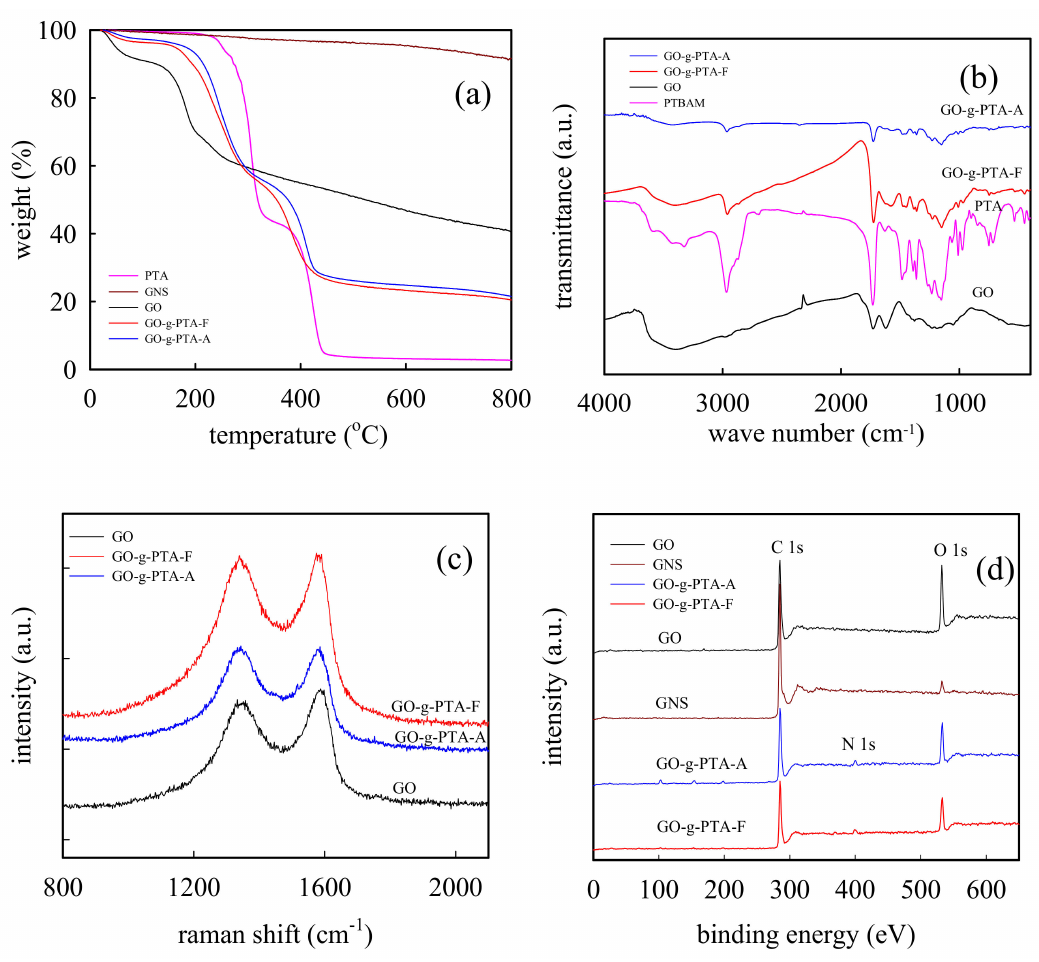
Figure 3. ( a ) TGA curves of the PTA, GO, GO- g -PTA-F, GO- g -PTA-A, and GNS in the nitrogen atmospheres at 10 ◦ C / min. ( b ) FTIR spectra of the PTA, GO, GO- g -PTA-F, and GO- g -PTA-A. ( c ) Raman spectra of GO, GO- g -PTA-F, and GO- g -PTA-A. ( d ) XPS spectra of GNS, GO, GO- g -PTA-F, and GO- g